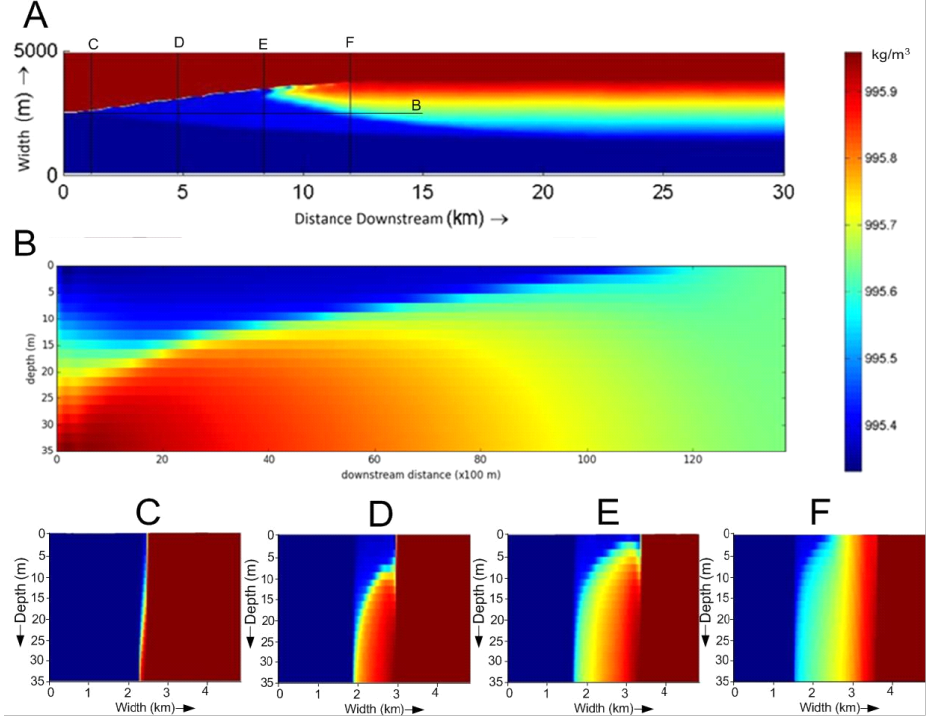
Figure 6. Density profiles in the base run simulation. ( A ) Top view. ( B ) Longitudinal cross-section